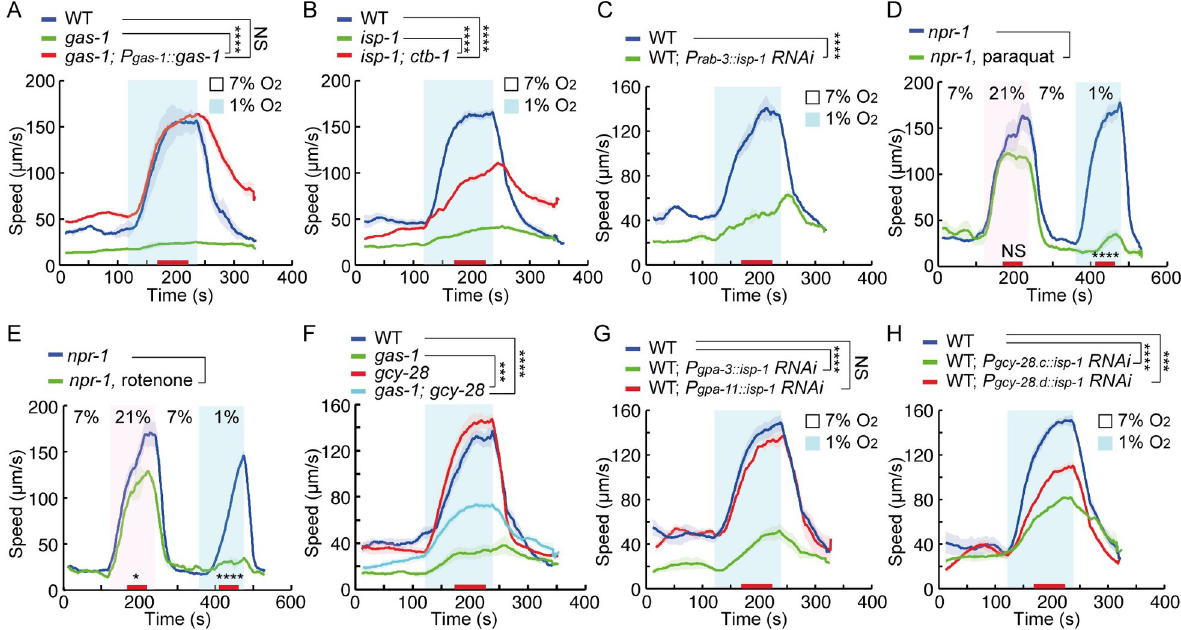
Fig 8. Mitochondrial malfunction leads to defects in acute hypoxia responses. (A) Locomotory responses to 7% to 1% O 2 stimuli of animals of indicated genotypes: WT, gas-1(fc21) and transgenic gas-1(fc21) mutants expressing gas-1 cDNA from the gas-1 promoter. ���� = p < 0.0001, NS = not significant. ANOVA, Tukey multiple comparison. (B) Locomotory responses of animals of indicated genotypes: WT, isp-1(qm150) and isp- 1(qm150); ctb-1(qm189) animals, to 7% to 1% O 2 switches. ���� = p < 0.0001, ANOVA, Tukey multiple comparison. (C) Locomotory responses to 7% to 1% O 2 stimuli of animals of indicated genotypes: WT, and WT expressing isp-1 RNAi constructs in the nervous system from the rab-3 promoter. ���� = p < 0.0001. Mann–Whitney U test. (D and E) Locomotory responses of npr-1(ad609) mutants to 21% (pink) and 1% O 2 (cyan) after treatment with either 200mM paraquat for 10 minutes (D), or 20 μ M rotenone for 2 hours (E). NS = not significant (21% O 2 ), � = p < 0.05 (21% O 2 ), ���� = p < 0.0001 (1% O 2 ). Mann–Whitney U test. (F) Locomotory responses to 7% to 1% O 2 stimuli for WT, gas-1(fc21) , gcy-28(yum28) , and gas-1(fc21); gcy-28(yum28) animals. ���� = p < 0.0001, ��� = p < 0.001. ANOVA, Tukey multiple comparison. (G) Locomotory responses to 7% to 1% O 2 stimuli of animals of indicated genotypes: WT, WT expressing isp-1 RNAi constructs from the gpa-3 (multiple neurons) or gpa-11 (ADL and ASH) promoters. ���� = p < 0.0001, NS = not significant. ANOVA, Tukey multiple comparison. (H) Locomotory responses to 7% to 1% O 2 stimuli of animals of indicated genotypes: WT, WT expressing isp-1 RNAi constructs under gcy-28 . c (multiple neurons) or gcy-28 . d (AIA neurons) promoters. ���� = p < 0.0001, ��� = p < 0.001. ANOVA, Tukey multiple comparison. The underlying data can be found in S1 Data, and the source code can be found at https://github.com/wormtracker/zentracker. RNAi, RNA interference; O 2 , oxygen; WT,